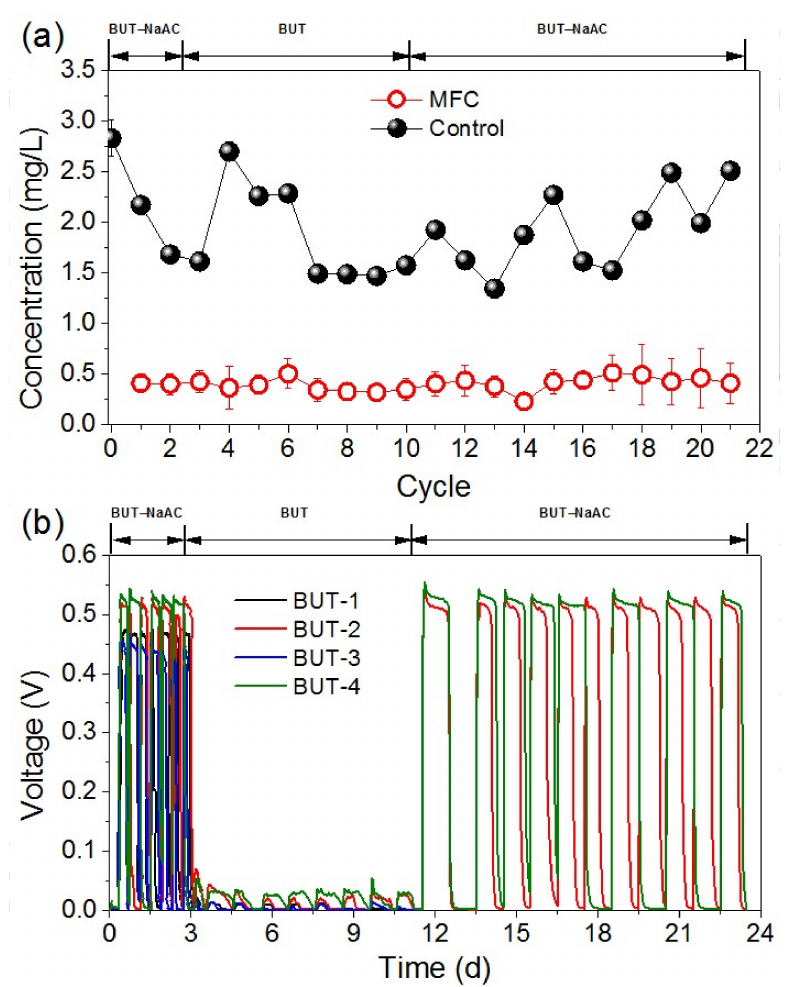
Figure 1. Butachlor concentration ( a ) and electricity production ( b ) in single-chamber microbial fuel cells (MFCs). Phase I: addition of butachlor and sodium acetate (BUT-NaAC), phase II: addition of only butachlor (BUT), and phase III: concomitant addition of butachlor and sodium acetate (BUT-NaAC). MFCs with NaAC as the sole carbon source were used as the control for electricity generation, while the removal rate of butachlor in a sample bottle under the same conditions was used as the control for non-MFC treatment. Bars denote the standard error. BUT-1, -2, -3, and -4 represent the four treatments with the addition of